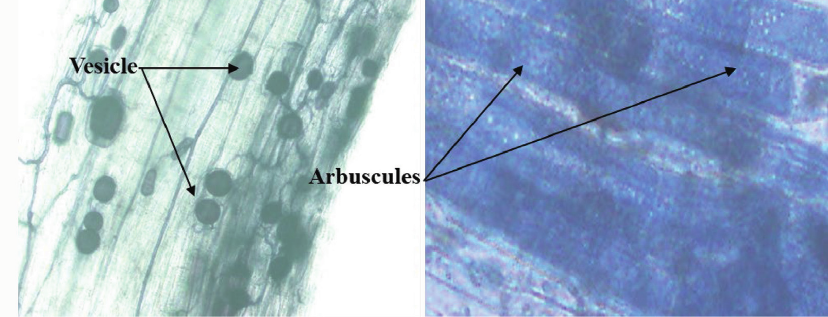
Figure 3: Carissa edulis roots that are infected with AMF showing vesicles and arbuscules within the root under × 50 fluorescent